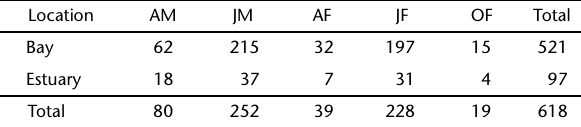
Table I. Number of individuals of Callinectes ornatus caught in the bay and estuary of São Vicente. (AM) Adult male, (JM) juvenile male,